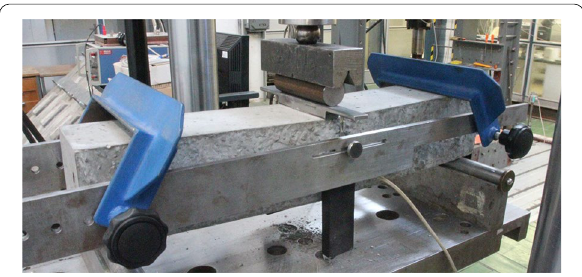
Fig. 11 The three-point bending experiment for the quasi-static